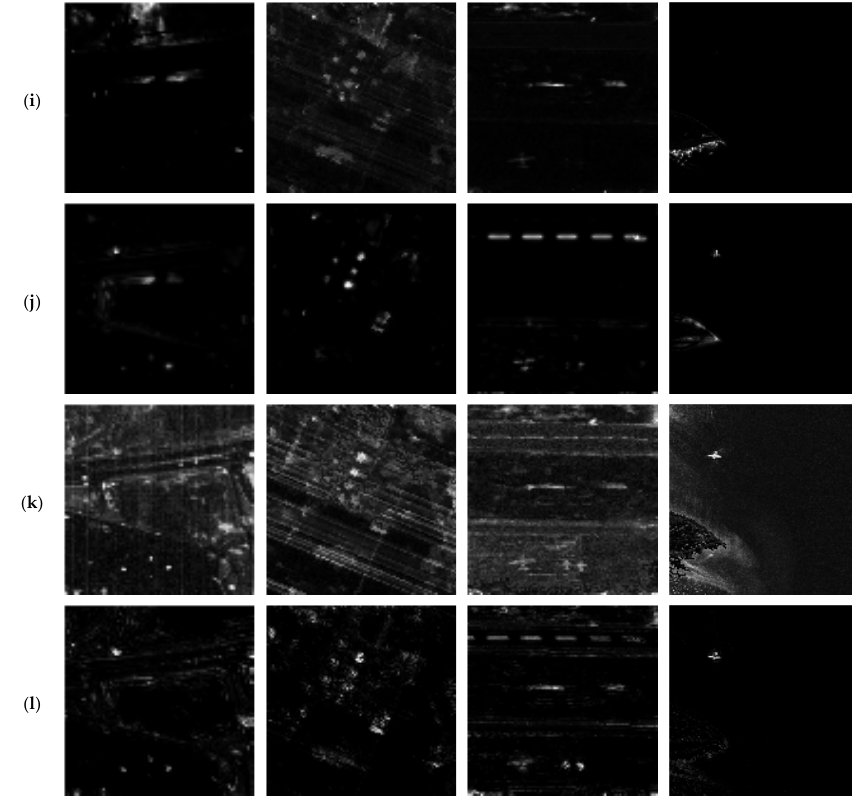
Figure 9. HSI-AD maps on four datasets. ( a ) RX; ( b ) LRX; ( c ) UNRS; ( d ) CRD; ( e ) LSAD; ( f ) LSUNRSORAD; ( g ) LSAD-CR-IDW; ( h ) CRDBPSW; ( i ) FEBPAD; ( j ) VABS; ( k ) KIFD; ( l ) SI2FM. Table 4. Ablation study of the proposed